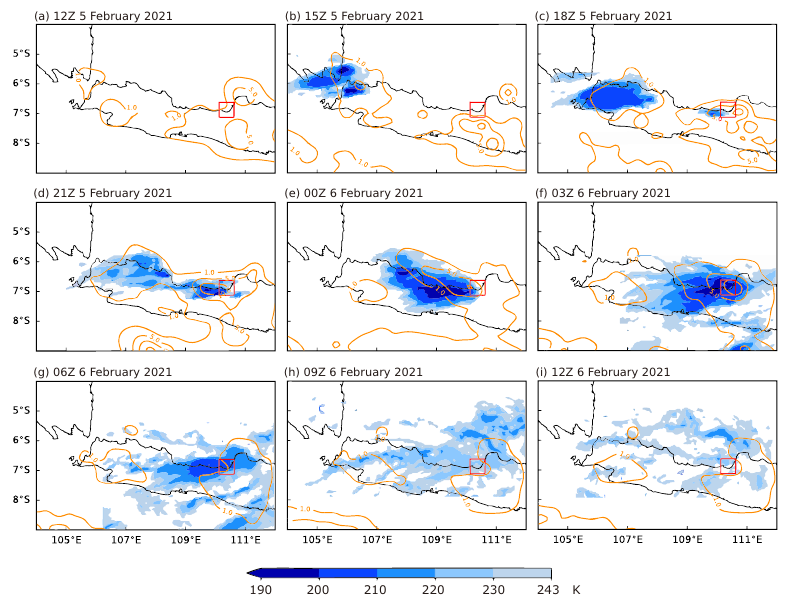
Figure 3. Three-hourly evolution of the MCS (K, shaded) from Himawari-8 satellite superimposed with rainfall rate from GSMaP (mm.h − 1 , contour) for the period of 5 February at 12Z to 6 February 2021 at 12Z. The location of Semarang is denoted by a red